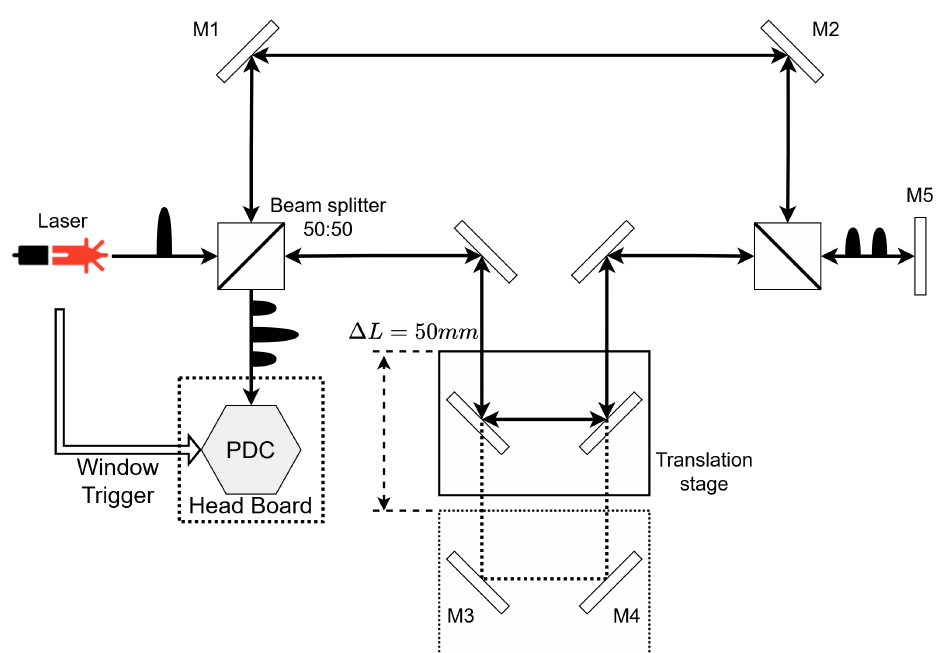
Figure 10. Basic MZI with a translation stage to control the time-bin separation. A mirror (M5) at the end makes the beam travel the MZI twice to mimic a full sender–receiver path.